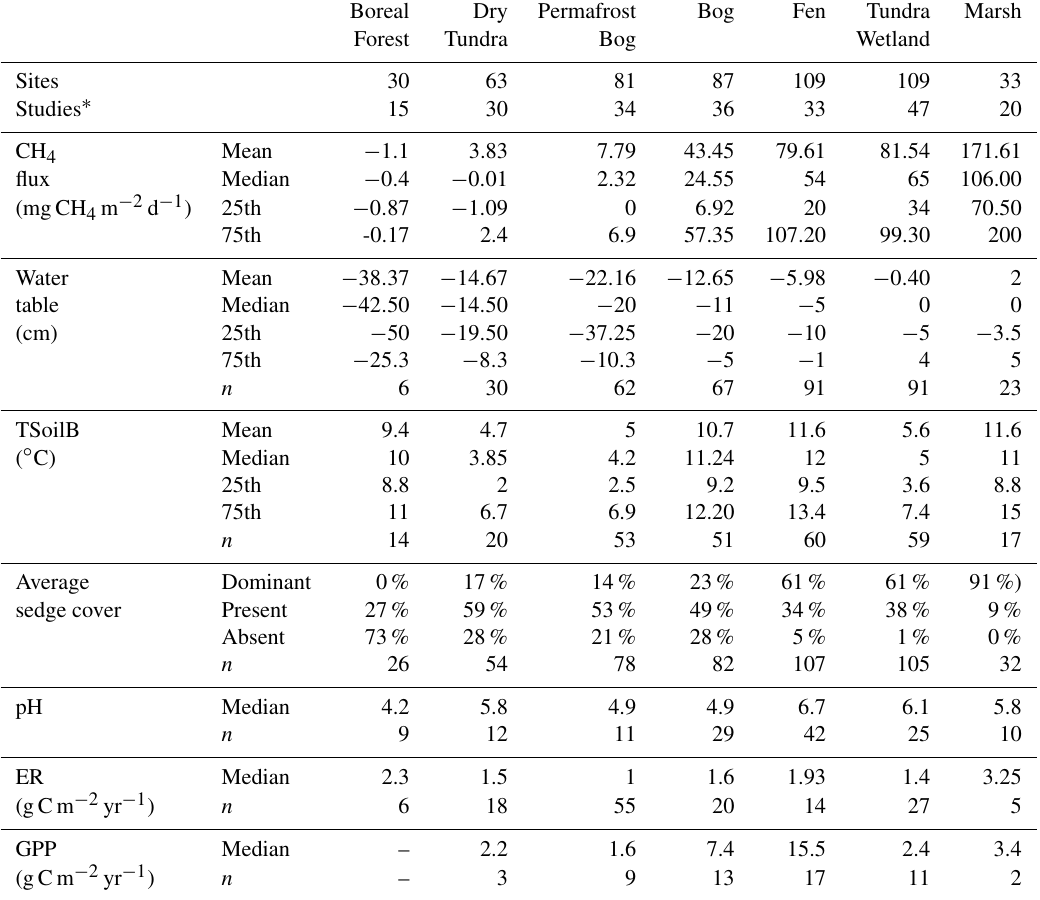
Table 3. Characteristics of BAWLD terrestrial classes based on environmental variables. The number of sites (site years) and contributing studies are shown for each class. Also shown are the mean, median, and quartiles for site-average CH 4 flux, water table, soil temperature between 5 and 25cm (TSoilB), sedge cover, pH, ecosystem respiration (ER), and gross primary productivity (GPP). ∗ In some cases, one study contributed flux data for multiple